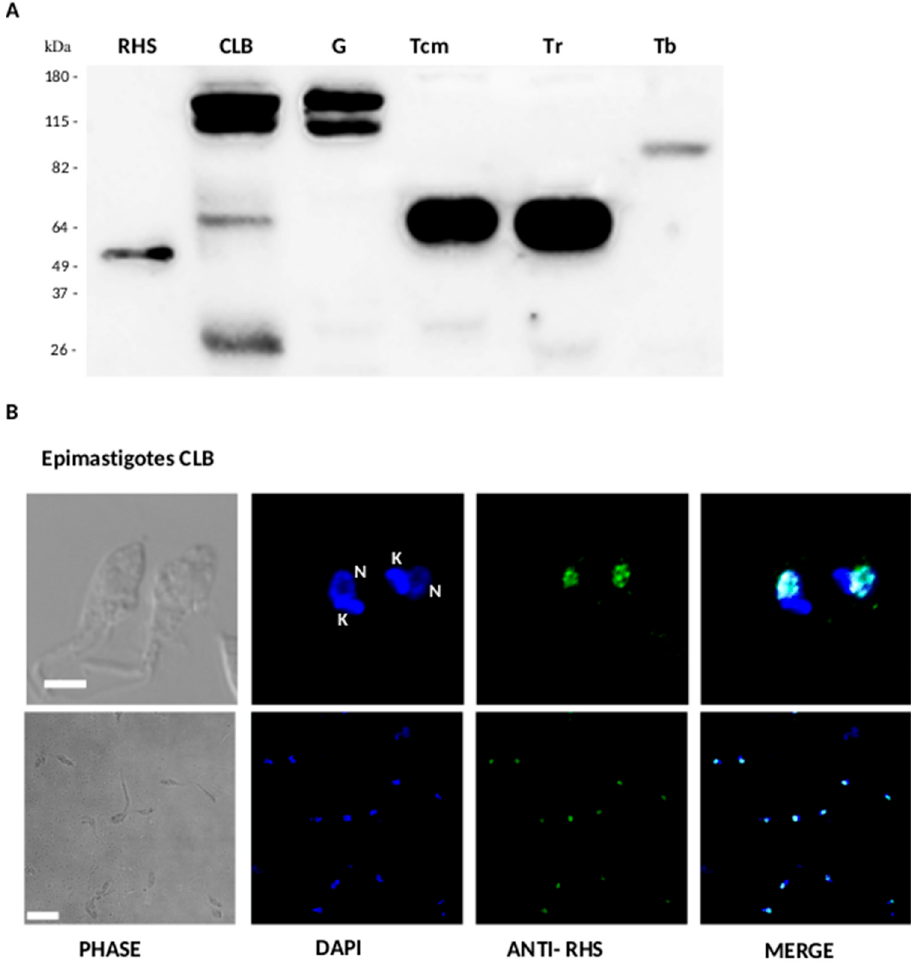
Figure 5. Analysis of the expression of RHS by Western blot in T. cruzi and other trypanosomes and cellular localization in T. cruzi by indirect immunofluorescence. ( A ) Protein extracts of epimastigotes of T. cruzi (CLB and strain G), T. cruzi marinkellei (Tcm), and T. rangeli (Tr) and procyclic forms of T. brucei (Tb) were separated by SDS-PAGE, transferred to nitrocellulose membranes, and incubated with anti-RHS polyclonal antibodies (diluted 1:500). The RHS recombinant protein was included as a positive control. The molecular masses of the reference proteins are indicated on the left in kDa. ( B ) Confocal microscopy images from indirect immunofluorescence reaction with anti-RHS antibodies (diluted 1:1000) in permeabilized epimastigotes of clone CLB. The labeling of the nucleus and kinetoplast DNA (DAPI) and RHS proteins is shown in blue and green, respectively. At the top, the reaction with two epimastigotes is shown at 3 µ m scale. In the lower panel, the image shows epimastigotes (scale bar 10 µ m). N, nucleus; K, kinetoplast. Permeabilized parasites were analyzed by indirect immunofluorescence, using anti-RHS